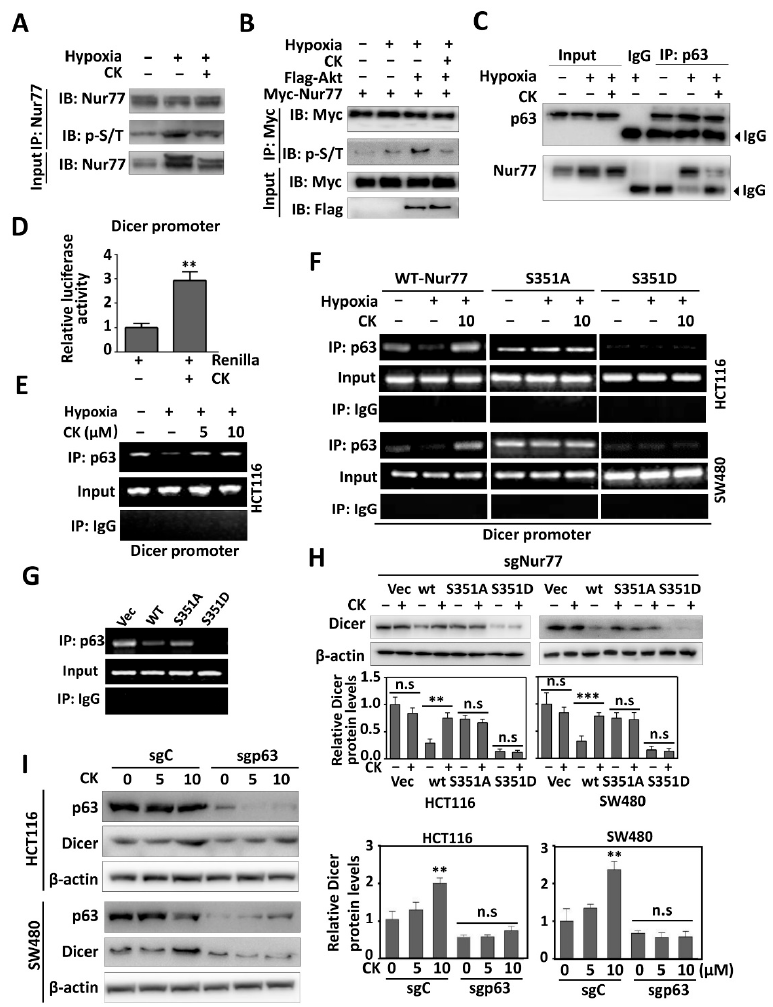
Figure 5. CK disrupts hypoxia-induced Nur77 interaction with p63 on the Dicer promoter by modulating Nur77 phosphorylation. ( A , B ) Untransfected and transfected HCT116 cells were cultured under normoxia or hypoxia. Hypoxic cells were treated with or without 10 µ M CK for 4 h. The lysates were immunoprecipitated with anti-Nur77 ( A ) or anti-Myc ( B ). The phosphorylation of Nur77 was examined with p-Ser/Thr (p-S/T) antibody. ( C ) The endogenous interaction between Nur77 and p63 was disrupted when HCT116 cells were exposed to 10 µ M CK treatment for 24 h. The cell lysates were immunoprecipitated with anti-p63 and blotted with antibodies against Nur77 and p63. ( D ) Reporter assay. HCT116 cells were co-transfected with Dicer promoter plasmid and renilla luciferase for 24 h and then exposed to 24 h of treatment with vehicle or 10 µ M CK. The luciferase activities were measured by Multiskan Spectrum (PerkinElmer, USA). The renilla fluorescence intensity was used to normalize for transfection efficiency. ( E , F ) HCT116 and its transfected cells with indicated expressing vectors were cultured under normoxia or hypoxia. Hypoxic cells were treated with vehicle, 5 µ M, or 10 µ M CK for 24 h. Cell lysates were immunoprecipitated with anti- p63 antibody and analyzed using specific Dicer promoter primers (ChIP assay). Nonspecific IgG was used as a negative control. ( G ) The metastatic tissues collected as indicated in Figure 3E were immunoprecipitated with anti-p63 antibody and subjected to the ChIP assay, as described above. ( H ) CRC cells harboring different expression vectors were treated with or without 10 µ M CK for 24 h. ( I ) p63/WT and p63/KO cells were treated with vehicle, 5 µ M, or 10 µ M CK for 24 h. For H and I, the levels of Dicer protein were detected and quantified by Western blotting. ** p < 0.01; *** p < 0.001 vs. respective control. n.s. = non-significant. sgC = sgControl. Molecular weights for proteins are indicated in the full, uncropped, annotated Western blot images (Figure